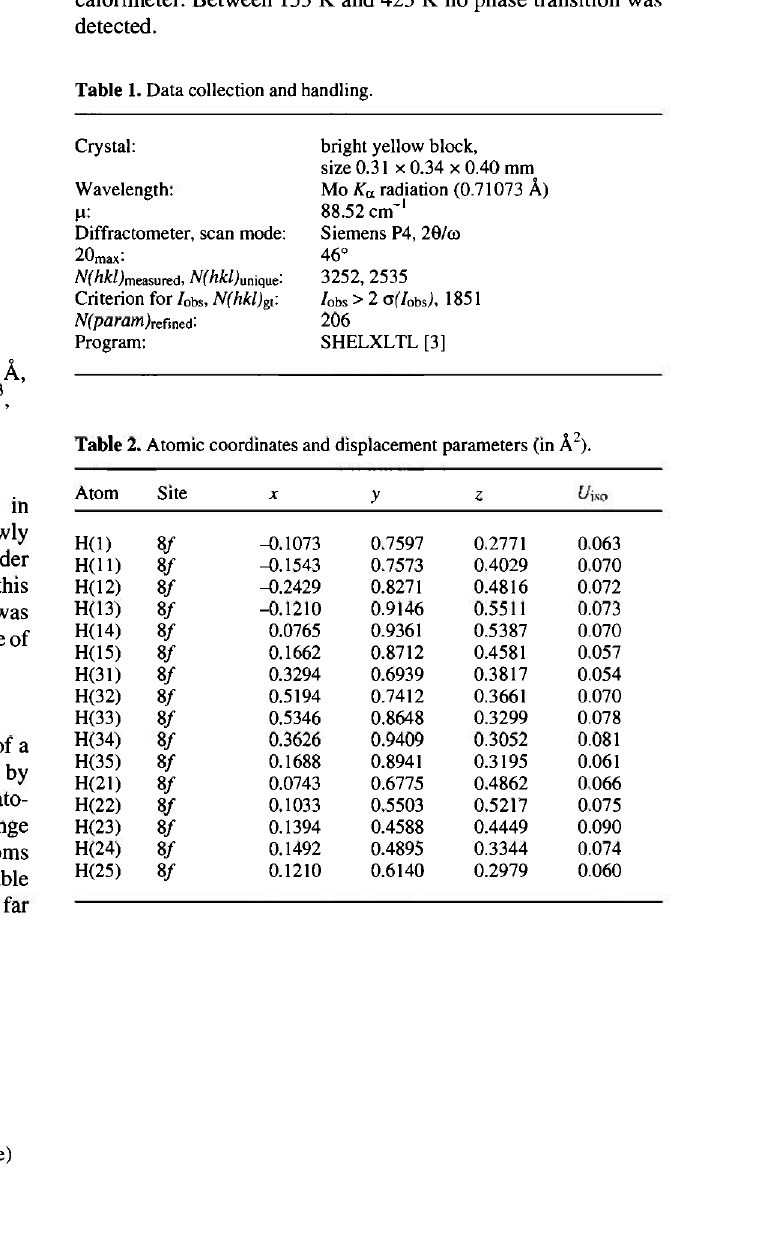
Table 1. Data collection and handling.